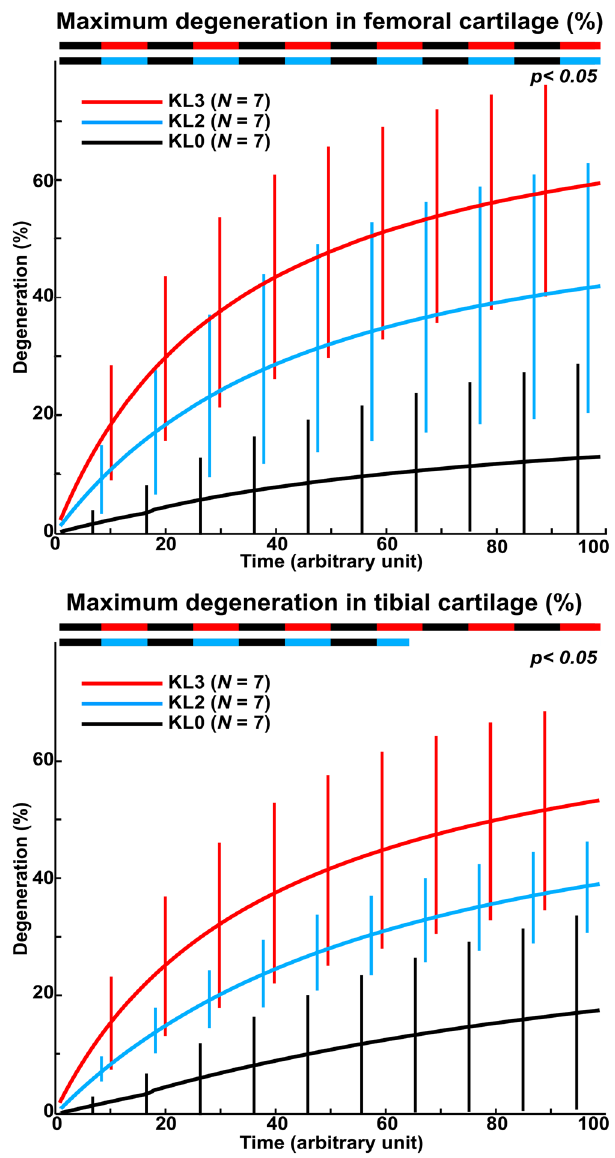
Figure 4. Maximum degeneration (mean ± 95% CI) as a function of time (arbitrary unit) in medial femoral (upper) and tibial (lower) cartilages. Two colored dashed lines represents significant differences between different